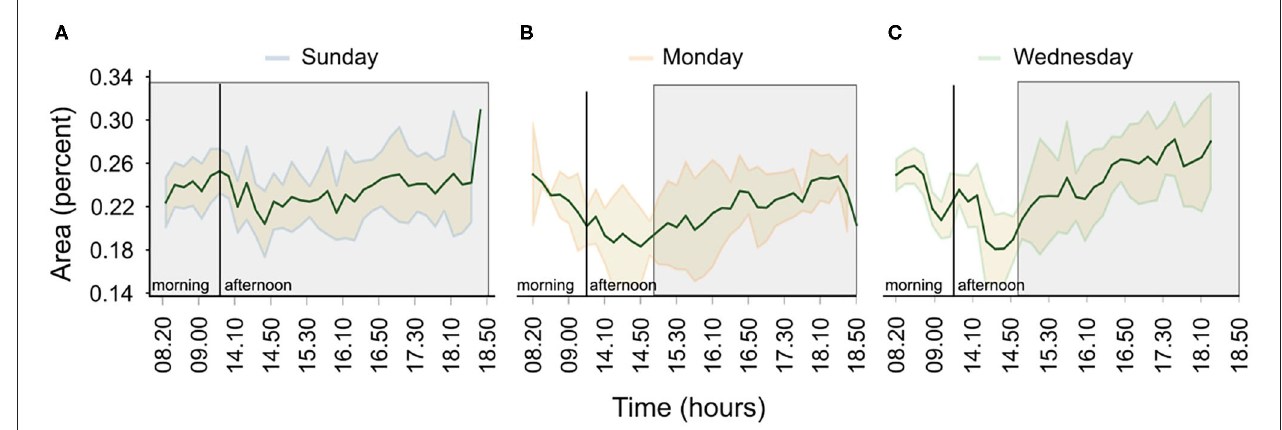
FIGURE 8 | Variations in the tank surface preference for the three scenarios; (A) no feeding/no human presence, (B) feeding after fasting/human presence, and (C) normal feeding/human presence. Shaded areas show the standard error of the mean and green solid lines the average area covered by the fish (in percent) over a period of a month. The gray shaded rectangles indicate periods of human